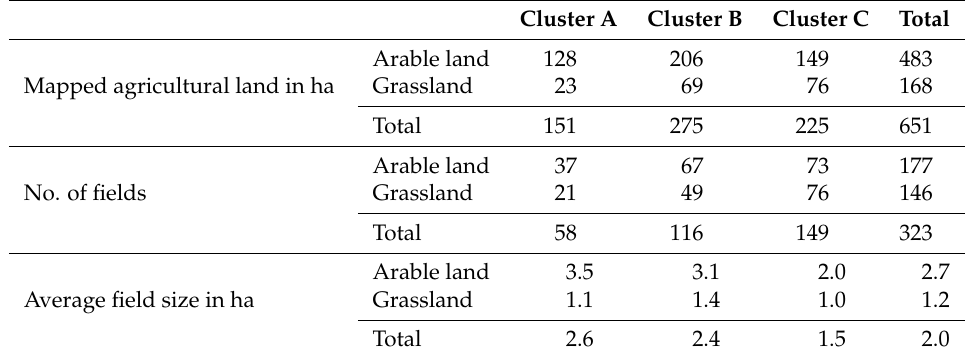
Table 2. Mapped agricultural land and number of fields per catchment and agricultural land use